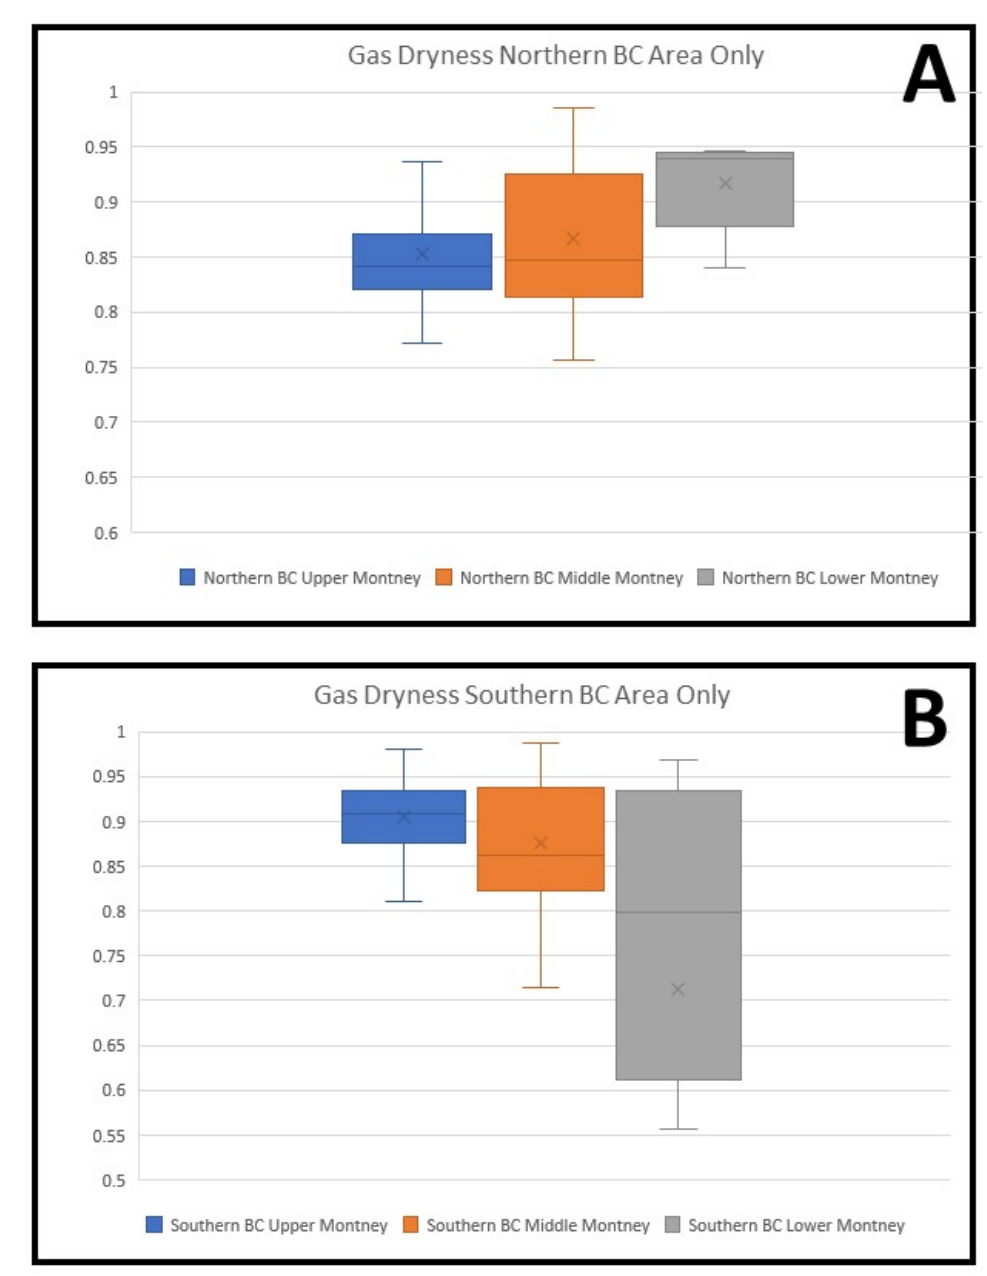
Figure 34. Box plot for the gas dryness ratio for northern ( A ) and southern regions ( B ) of British Columbia (BC). See Figure 2 for the location of these regions. There are no consistent trends between the Upper, Middle, and Lower Montney subunits when comparing the hydrocarbon compositions. The Montney formation becomes drier in hydrocarbon composition from the Upper to Middle to Lower Montney subunits in the northern region of BC. The reverse is true in the southern region of BC. The number of samples are n = 78 for Northern BC Upper Montney wells, n = 159 for Southern BC Upper Montney wells, n = 135 for Northern BC Middle Montney wells, n = 7 for Northern BC Lower Montney wells, n = 159 for Southern BC Upper Montney wells, n = 98 for Southern BC Middle Montney wells, and n = 7 for Southern BC Lower Montney wells.